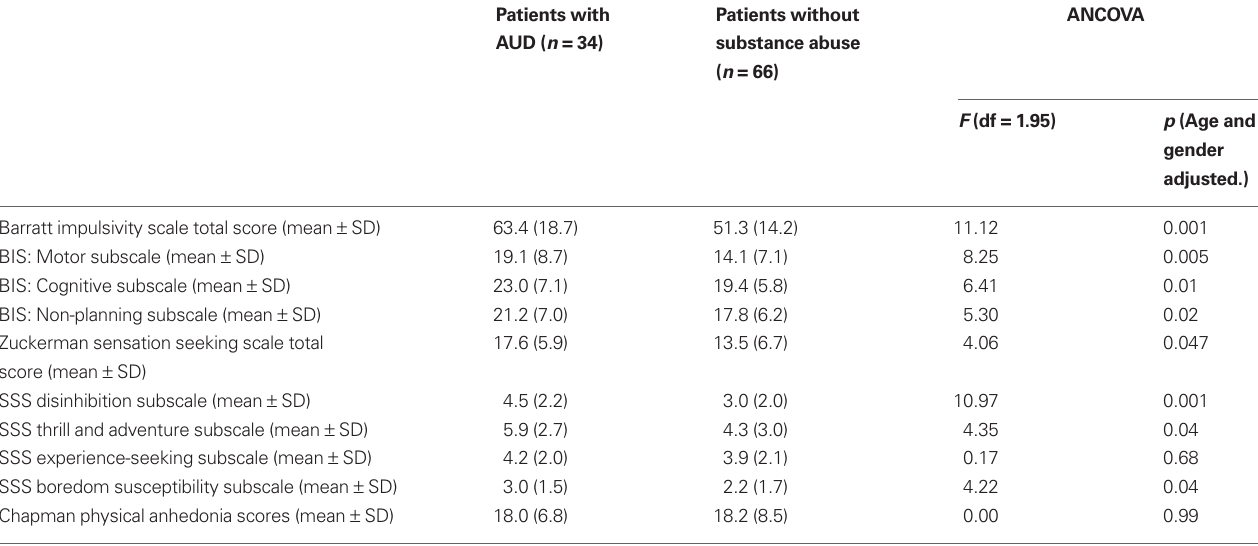
Table 1 | Impulsivity and sensation seeking score ratings in schizophrenia patients with lifetime AUD (alcohol abuse or dependence) or without substance